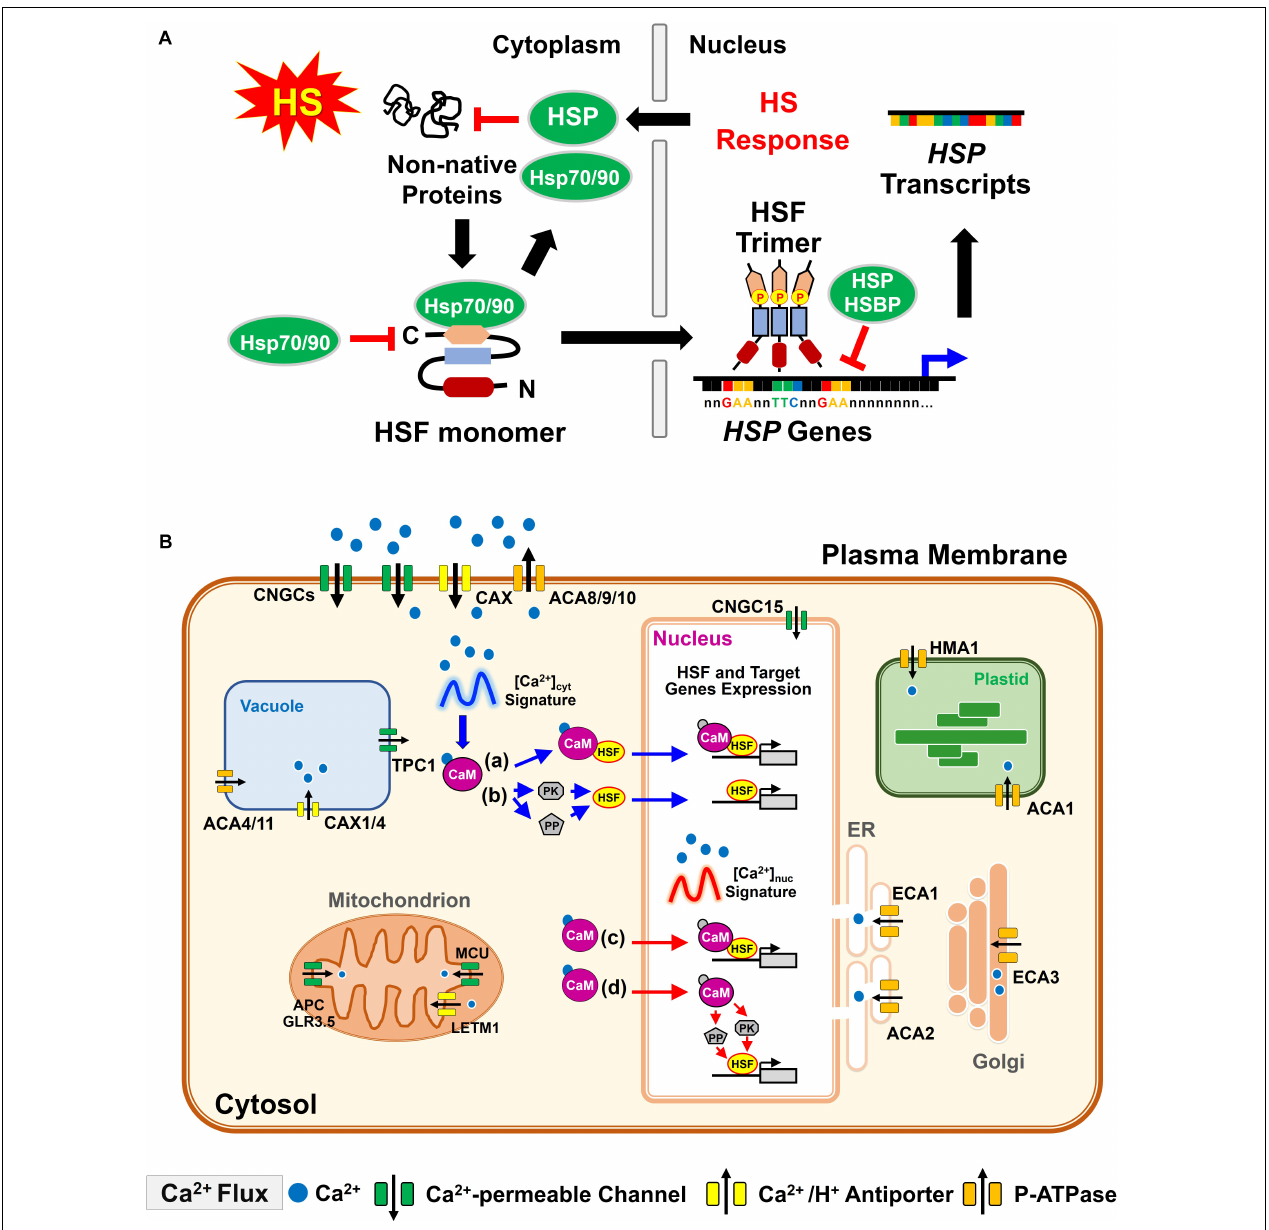
FIGURE 2 | Basic function of plant HSF and HS-induced [Ca 2 + ] cyt / nuc oscillation interpretation by CaM in response to heat. (A) Under unstressed conditions, Hsp70/HspP90 can directly regulate the function of HSF by blocking its transcriptional activity. Upon HS, non-native proteins induce the conversion of monomeric HSF into an active trimeric form, which is phosphorylated and translocated into the nucleus. HSF trimer, with high-affinity DNA binding capacity to the HSE (5 (cid:48) -nGAAnnTTCnnGAAn-3 (cid:48) ) of the HSP gene promoter region, activates HSP gene expression, whereas it is downregulated by the interaction of HSP and HSBP with the HSF trimer to attenuate HSR in plants. HSP production and relocation to the cytoplasm inhibits non-native protein misfolding and aggregation. (B) Cellular Ca 2 + transport is tightly controlled within all membrane-bound organisms during heat stress. An increase in [Ca 2 + ] cyt is manifested by Ca 2 + influx to the cytosol, mediated by Ca 2 + -permeable ion channels, either from the apoplast across the plasma membrane, or from intracellular stores such as the endoplasmic reticulum or vacuole. In contrast, Ca 2 + -ATPases and the Ca 2 + /H + antiporter systems are responsible for Ca 2 + extrusion out of the cytosol. HS-elevated Ca 2 + occurs from apoplast entry to the cytosol or nucleus (either diffused from the cytosol or released from nuclear Ca 2 + reservoirs). The CaM responds to the elevation of [Ca 2 + ] cyt signature to modulate the activity of numerous target proteins. (a) and (c) The Ca 2 + /CaM complex interacts with the HS transcription factors (HSFs) and modulates either HSF DNA-binding or transcriptional activities. (b,d) The Ca 2 + /CaM complex regulates the activation of HSF by modulating the phosphorylation status. The regulation is achieved by CaM-binding protein kinase (PK) or CaM binding protein phosphatase (PP). (c,d) CaM recognizes a high frequency and magnitude of the cytosolic Ca 2 + signature and is translocated into the nucleus for responding to the nuclear [Ca 2 + ] ([Ca 2 + ] nuc ) to bind or regulate the status of HSF phosphorylation in the nucleus. ACAs, autoinhibited Ca 2 + -ATPases; APC, adenine nucleotide/phosphate carrier; CAXs, Ca 2 + /H + cation antiporters; CNGC, cyclic nucleotide-gated ion channels; ECAs, ER-type calcium ATPases; GLR3.5, glutamate receptor 3.5; HMA1, heavy metal translocating P-type ATPase; LETM1; leucine zipper-EF-hand-containing transmembrane protein 1; MCU, mitochondrial calcium uniporter; TPC1, two-pore voltage-gated channel 1.